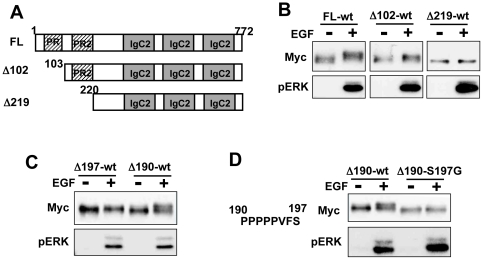
Ser197 is phosphorylated by EGF stimulation.(A) Schematic representation of palladin deletion constructs. (B) Mobility shift of mutant palladin after EGF stimulation was examined by western blot. Vero cells were transfected with Myc-tagged mutant palladin. Twenty-four hours later, serum-starved cells were stimulated with or without EGF for 5 min and lysed for western blot analysis. Lower panel shows ERK phosphorylation. (C) Mobility shift of mutant palladin after EGF stimulation was examined by western blotting. (D) Mobility shifts of Δ190-wt and Δ190-S190G after EGF stimulation were examined by western blotting. Amino acid sequence from 190–197 is indicated.